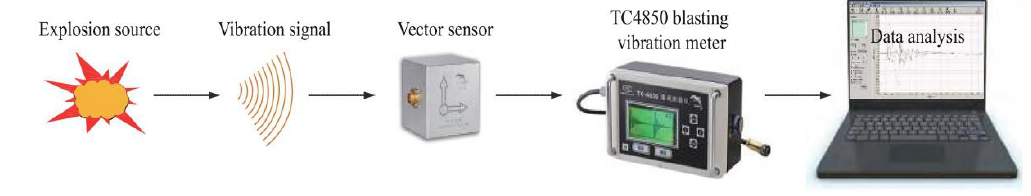
Figure 3. Monitoring